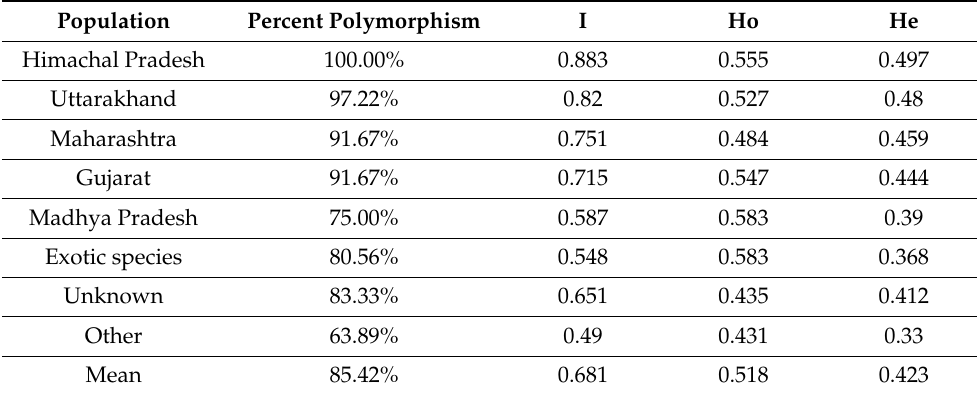
Table 2. Percentage of polymorphic loci detected by 36 g-SSR markers across A. hypochondriacus populations,